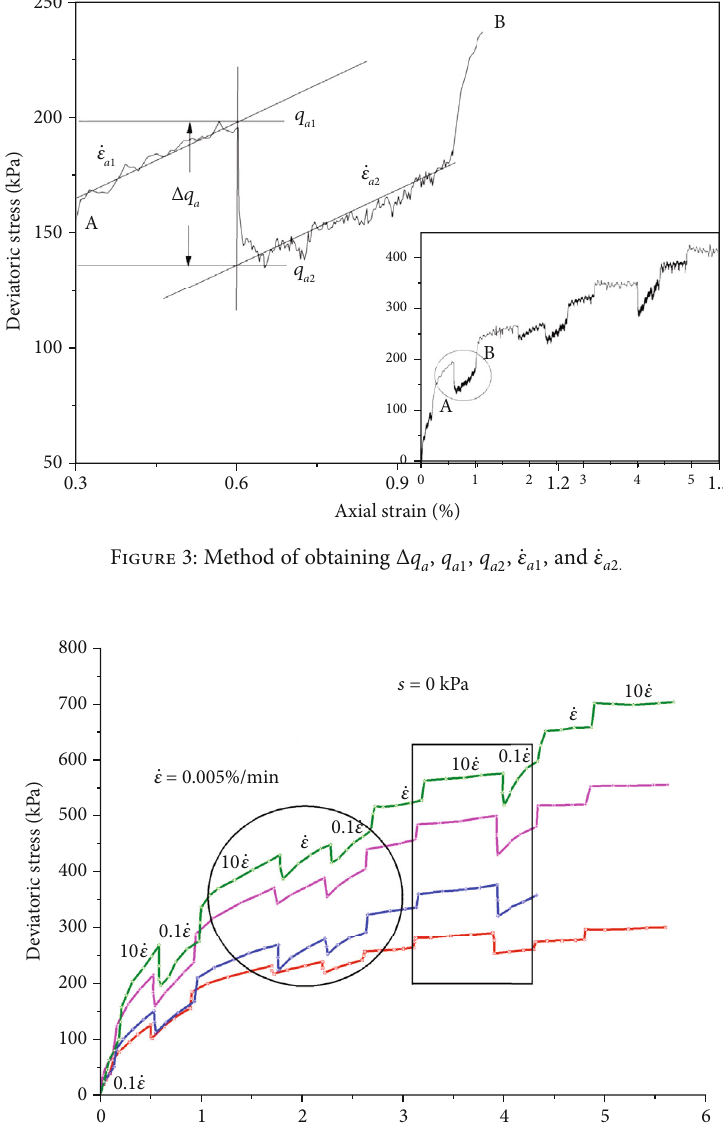
- σ ) – ε summary curves ( s = 0kPa 1 3 a